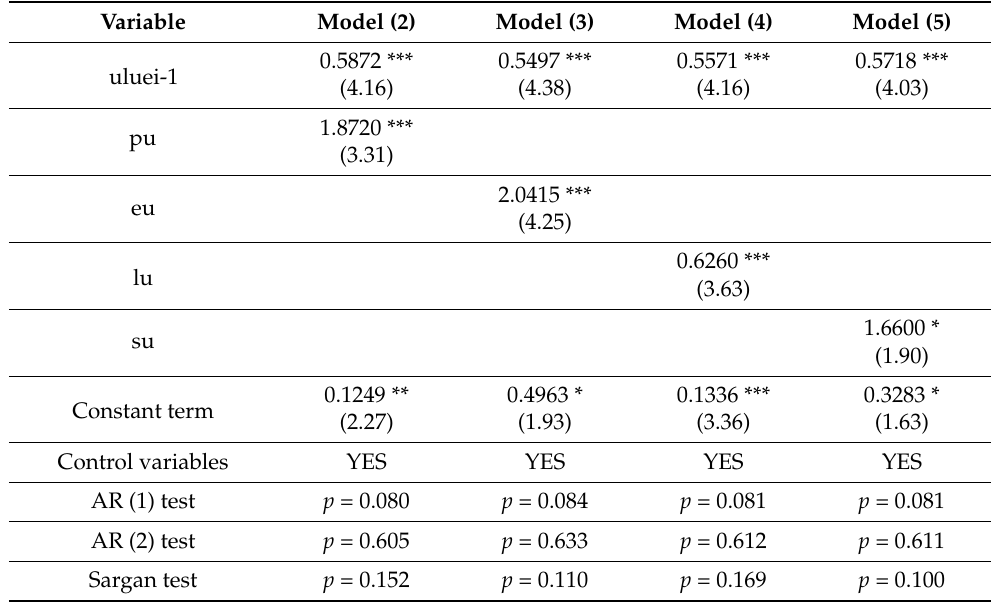
Table 6. Results of the impact of the N-TU subsystems on the